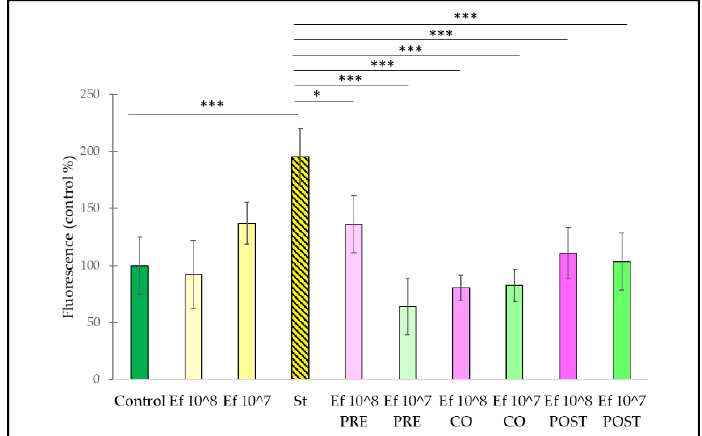
Figure 10. Effect of E. faecium on the paracellular permeability of IPEC-J2 cells treated with S. Typhimurium. E. faecium was added 1 h before (pre-treatment), at the same time (co-treatment) and 1 h after (post-treatment) the addition of S. Typhimurium. Detection of the FD4 dye was performed 24 after the treatment of S. Typhimurium. Control : plain cell culture medium treat- ment; Ef 10ˆ8 : E. faecium 10 8 CFU/mL; Ef 10ˆ7 : E. faecium 10 7 CFU/mL ; Ef 10ˆ8 PRE : pre-treatment with E. faecium 10 8 CFU/mL + S. Typhimurium 10 6 CFU/mL; Ef 10ˆ7 PRE : pre-treatment with